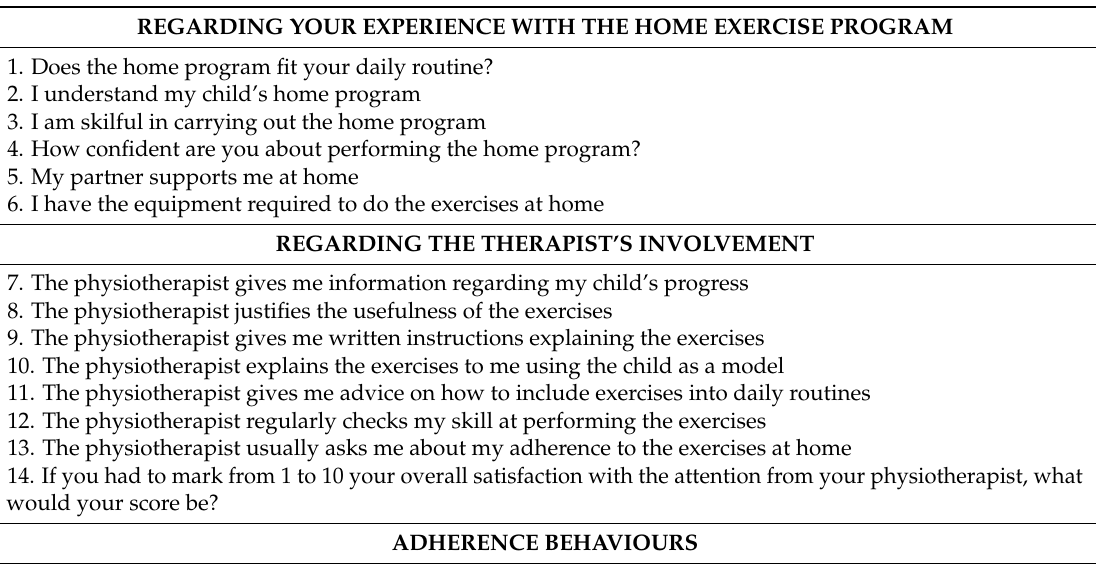
Table A1. Questionnaire of Parents’ Adherence to Home Exercise Programs Item scoring, and scales for Questionnaire of Parents’ Adherence to Home Exercise Programs.